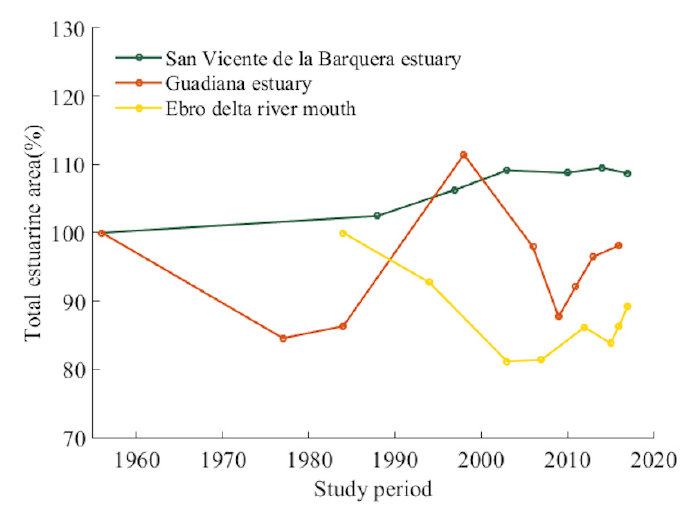
Figure 6. Temporal changes in the total occupied surface of the three study zones, referred to the initial area (ha) considered in the study period. Note the difference in reference time for the Ebro case.